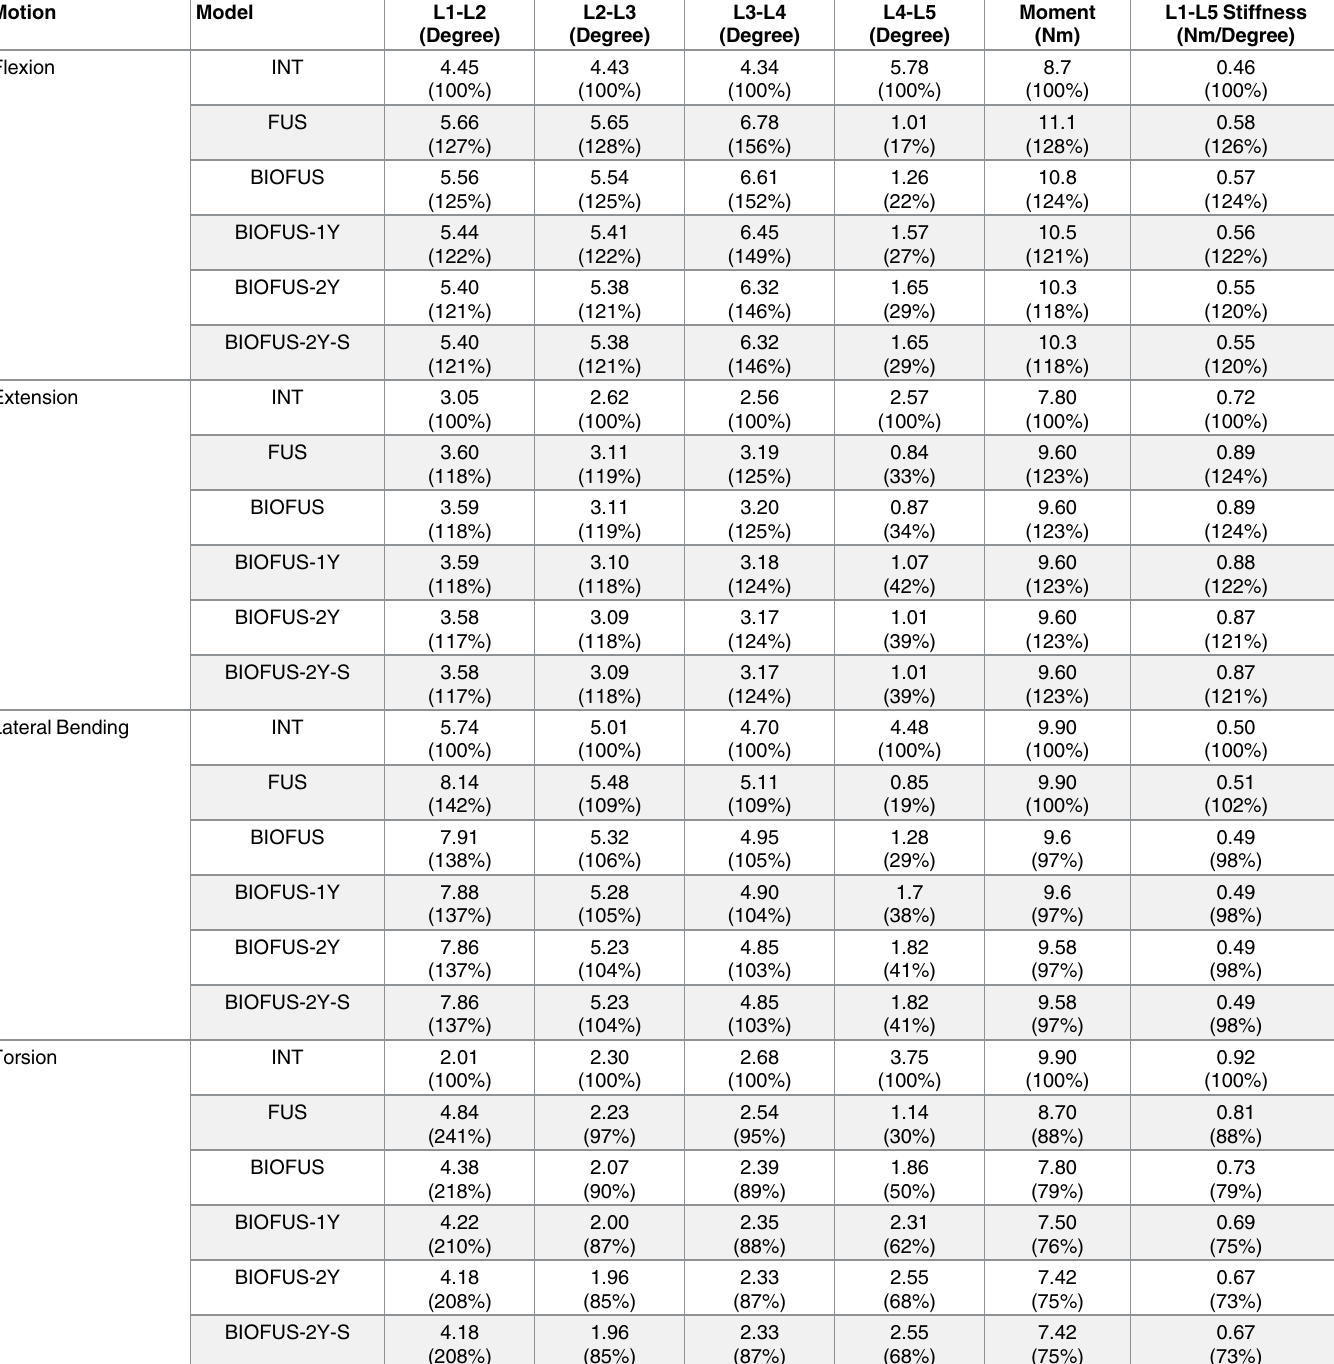
Table 1. ROM of six FE models at all motion segments.